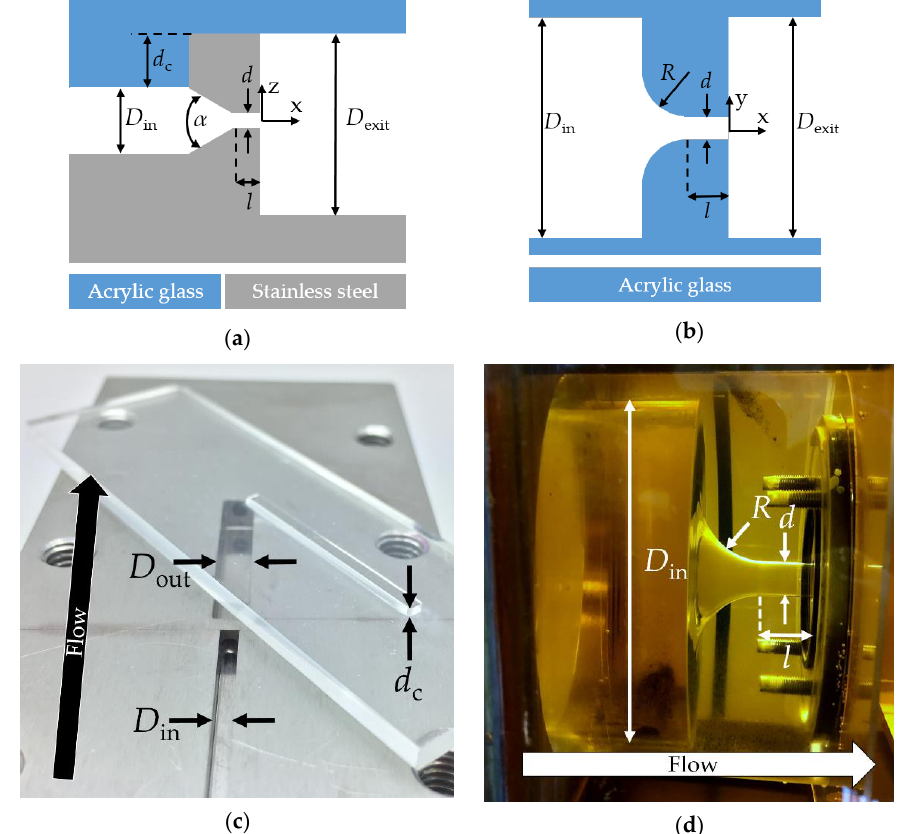
Figure 4. Geometry of the original and the 5-fold scaled orifice: ( a ) geometry of the 50-fold scaled orifice and ( b ) image of the original scale orifice with demounted acrylic glass cover plate (flow from bottom to top). The protrude bar on the acrylic glass plate is fitted in the inlet channel ( c ); image of the 50-fold scaled orifice (flow from left to right) ( d ). The related dimensions can be found in Table 2.